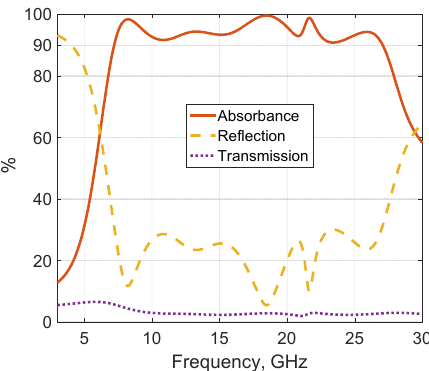
Figure 2. Simulated results of the proposed absorber.